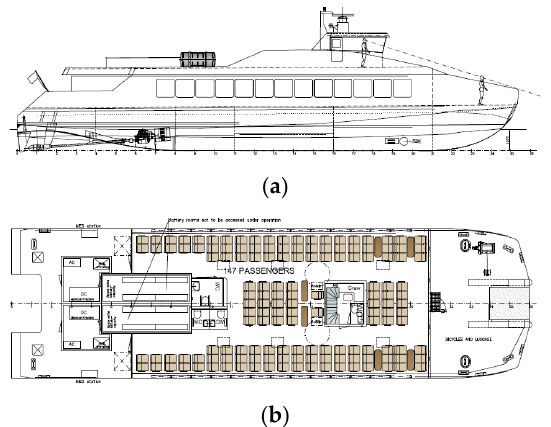
Figure 1. Preliminary general arrangement of the Stavanger Demonstrator. ( a ) side profile ( b ) main deck plan.